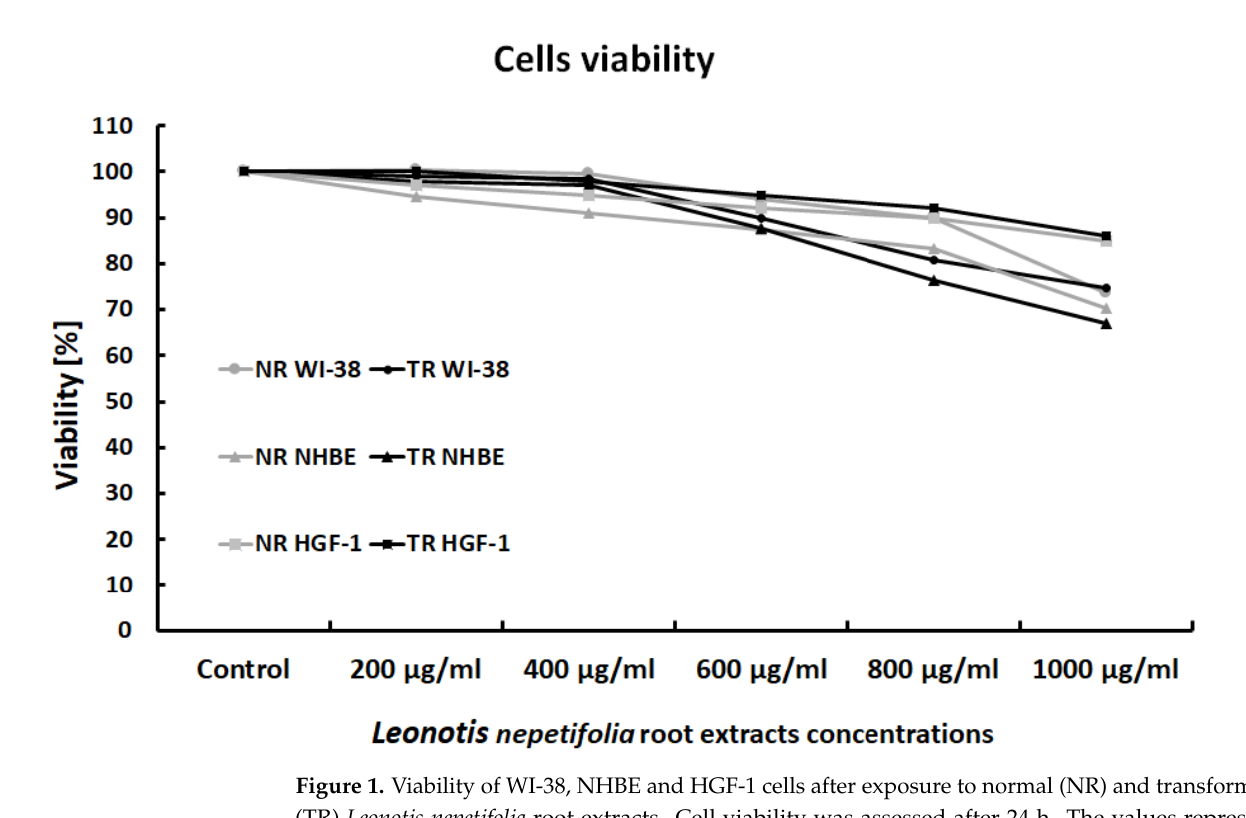
Figure 1. Viability of WI-38, NHBE and HGF-1 cells after exposure to normal (NR) and transformed (TR) Leonotis nepetifolia root extracts. Cell viability was assessed after 24 h. The values represent mean viability.